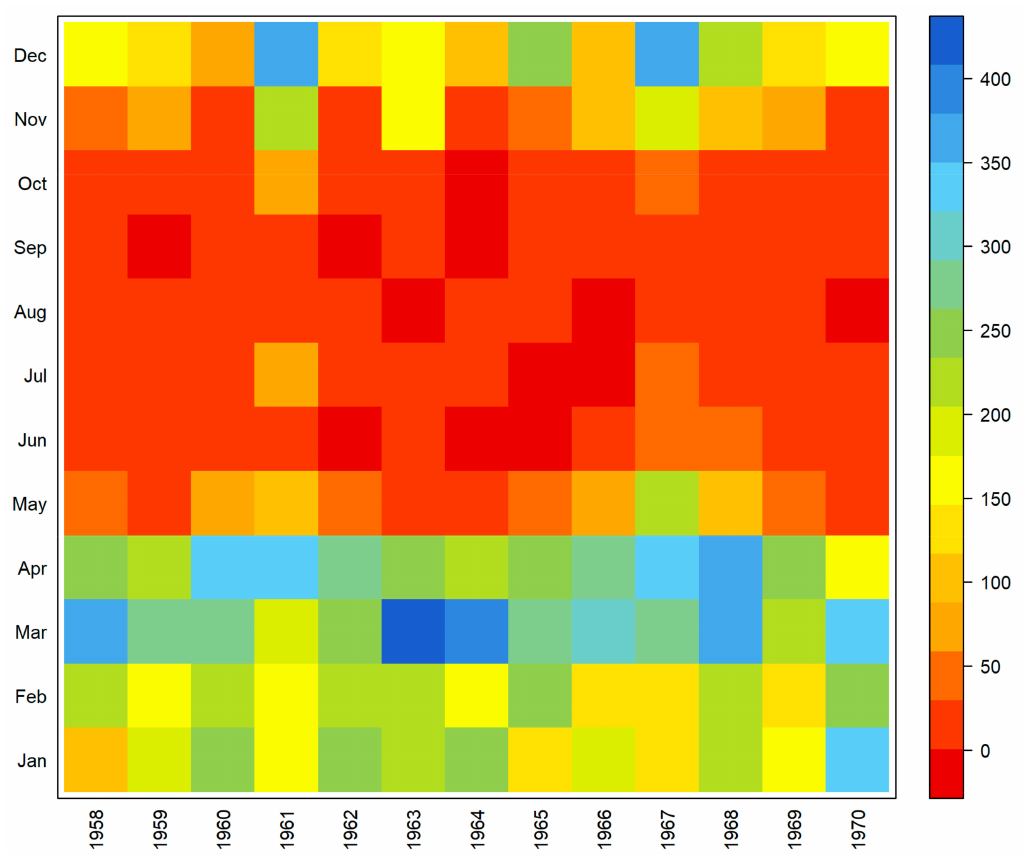
Figure 7. Matrix illustrating the mean monthly areal precipitation (mm) patterns within the simulation period (1958–1970) for the Kilombero